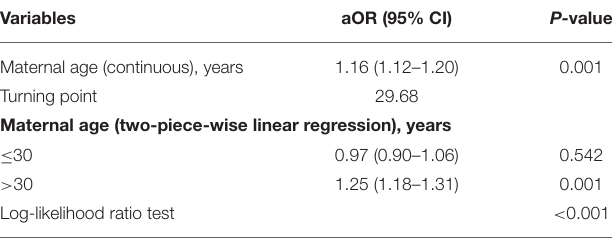
aOR, adjusted odds ratio; CI, confidence interval. Adjusts for: maternal ethnicity, maternal education, maternal occupation, maternal income, maternal body mass index, parity, folic acid supplementation, multivitamins supplementation, and medication